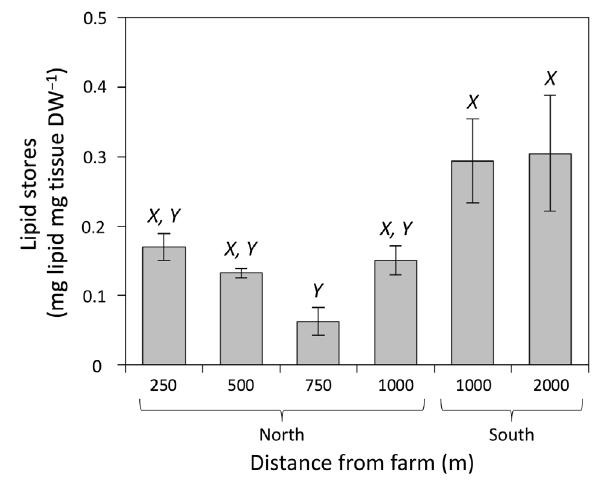
Fig. 4. Linear extension (mean ± SE, mm yr −1 ) of Lophelia pertusa coral fragments after 1 yr of transplantation from Kjerringrevet (a nearby cold-water coral reef) to a gradient away from a salmon fish farm. n = 6 for all sites. Letters above the bars show statistically distinct groups as identified by Tukey’s HSD test (p < 0.05). DW: dry